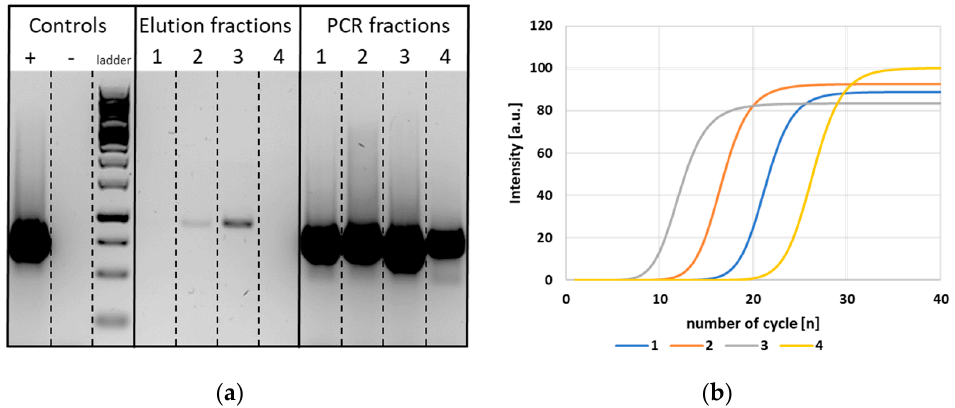
Figure 8. DNA samples eluted after fiber-electrophoresis and used as a template for PCR and real- time PCR. ( a ) A volume of 10 µL of each elution fraction was loaded directly on a 1% agarose gel. A PCR with primers for the 910 bp fragment and 1 µL of each elution fraction was performed and the final DNA samples were separated via agarose gel electrophoresis next to the elution fractions. ( b ) The graphs depict the intensities measured upon real-time PCR using the same primers and SyGreen. The numbers 1–4 refer to the position of the chip segments from left to right. The curves appearing first in real-time PCR were consistent with the most intense bands of the elution fractions. In both PCR and real-time PCR, the sample fragment loaded on fiber-electrophoresis can also be amplified if it is not seen in the elution fractions.